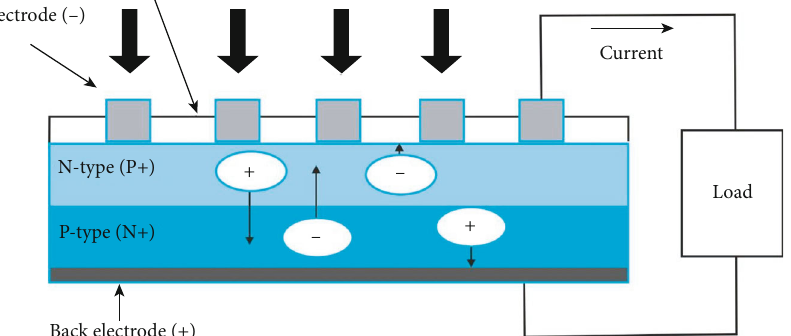
Figure 10: A p-n junction SPV cell structure